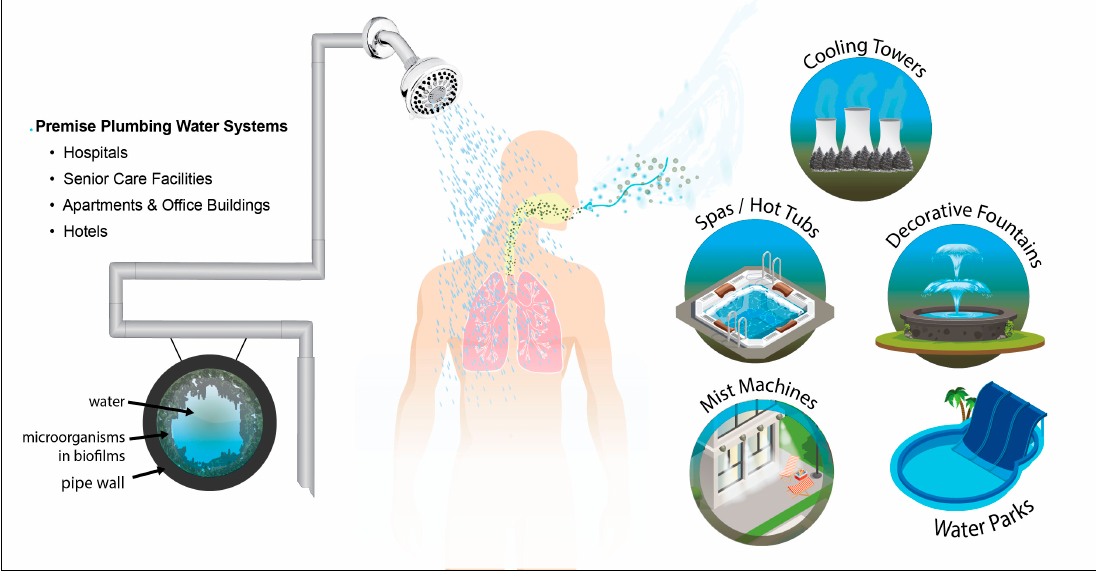
Figure 1. Common source of Legionella transmission.